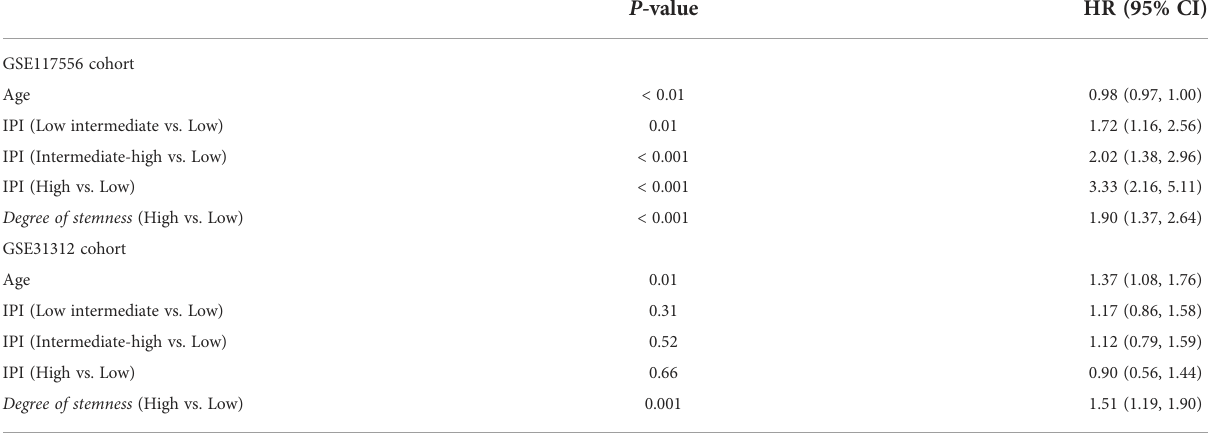
TABLE 2 Multi-variable Cox regression analyses of clinical co-variates, degree of stemness and progression-free survival.